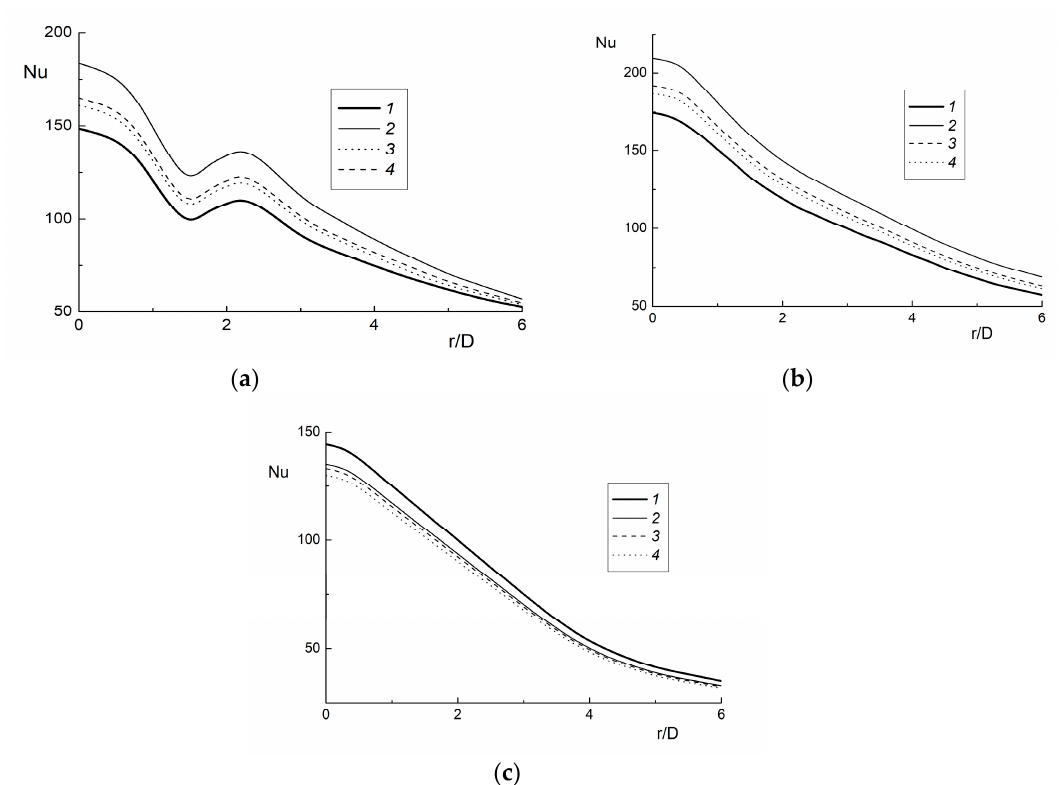
Figure 9. Radial distributions of local Nusselt numbers along the plate length of various forms of signal at H / D = 2 ( a ), 6 ( b ) and 10 ( c ). Re = 23000, U m 1 = 17.5 m/s, T W = 373 K, T 1 = 293 K, DC = 0.5, f = 150 Hz, St = 0.18. 1 —steady-state impinging jet, 2 —rectangular; 3 —sinusoidal, 4 —triangle.